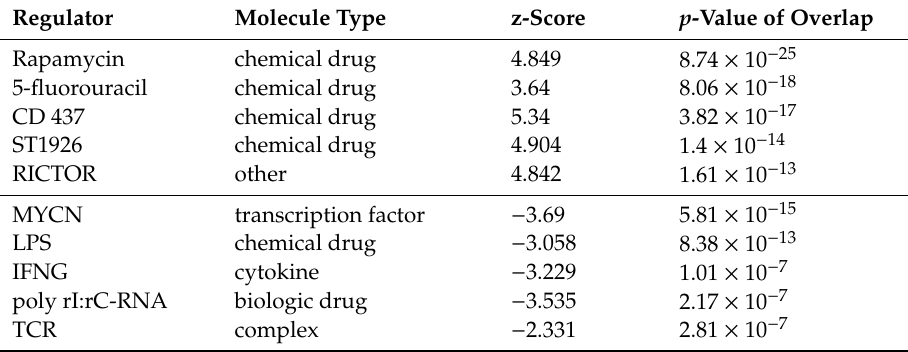
Table 3. Upstream regulators of ex vivo